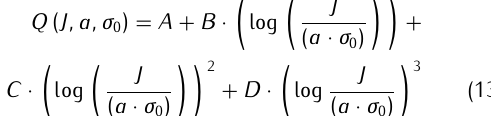
Figure 12. Theinfluenceoftheworkhardeningexponenton J - Q tra- jectories for SEN(T) specimens: a) SEN(T), a / W =0.20, σ 0 =315MPa; b) SEN(T), a / W =0.50, σ 0 =500MPa.